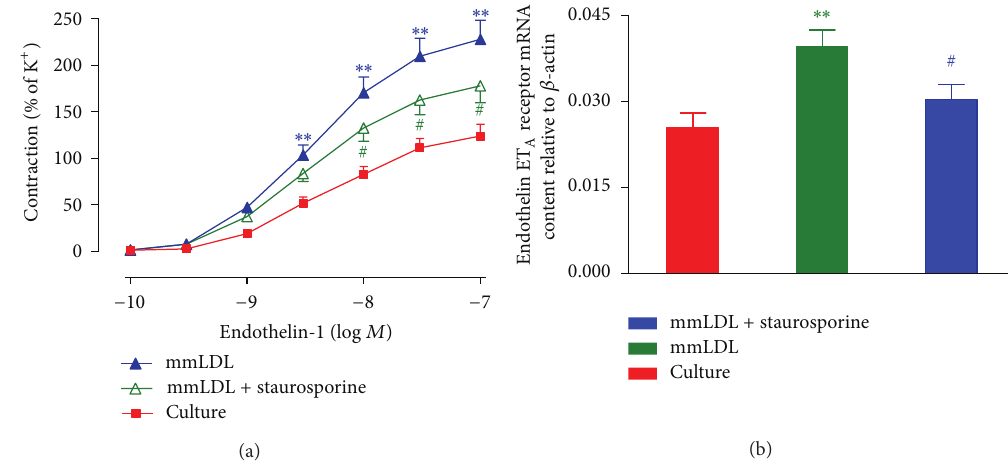
Figure 3: Effect of a PKC inhibitor on the mmLDL induced increase in contractile function and mRNA levels of ET A receptor in the rat coronary artery. After the coronary artery rings were cultured for 24h with mmLDL (10 𝜇 g/mL) in the presence of the PKC inhibitor staurosporine (0.1 𝜇 M), the concentration-contraction curves of the rings mediated by ET A receptor ((a) 𝑛 = 8 coronary arteries, from that number of animals) and the levels of the ET A receptor mRNA ((b) 𝑛 = 5 -6 coronary arteries, from that number of animals) were determined. Staurosporine inhibited the mmLDL-induced increase in ET A receptor contractile function and mRNA expression. The data are presented as the mean ± SEM. ∗∗ 𝑃 < 0.01 versus culture, # 𝑃 < 0.05 , versus